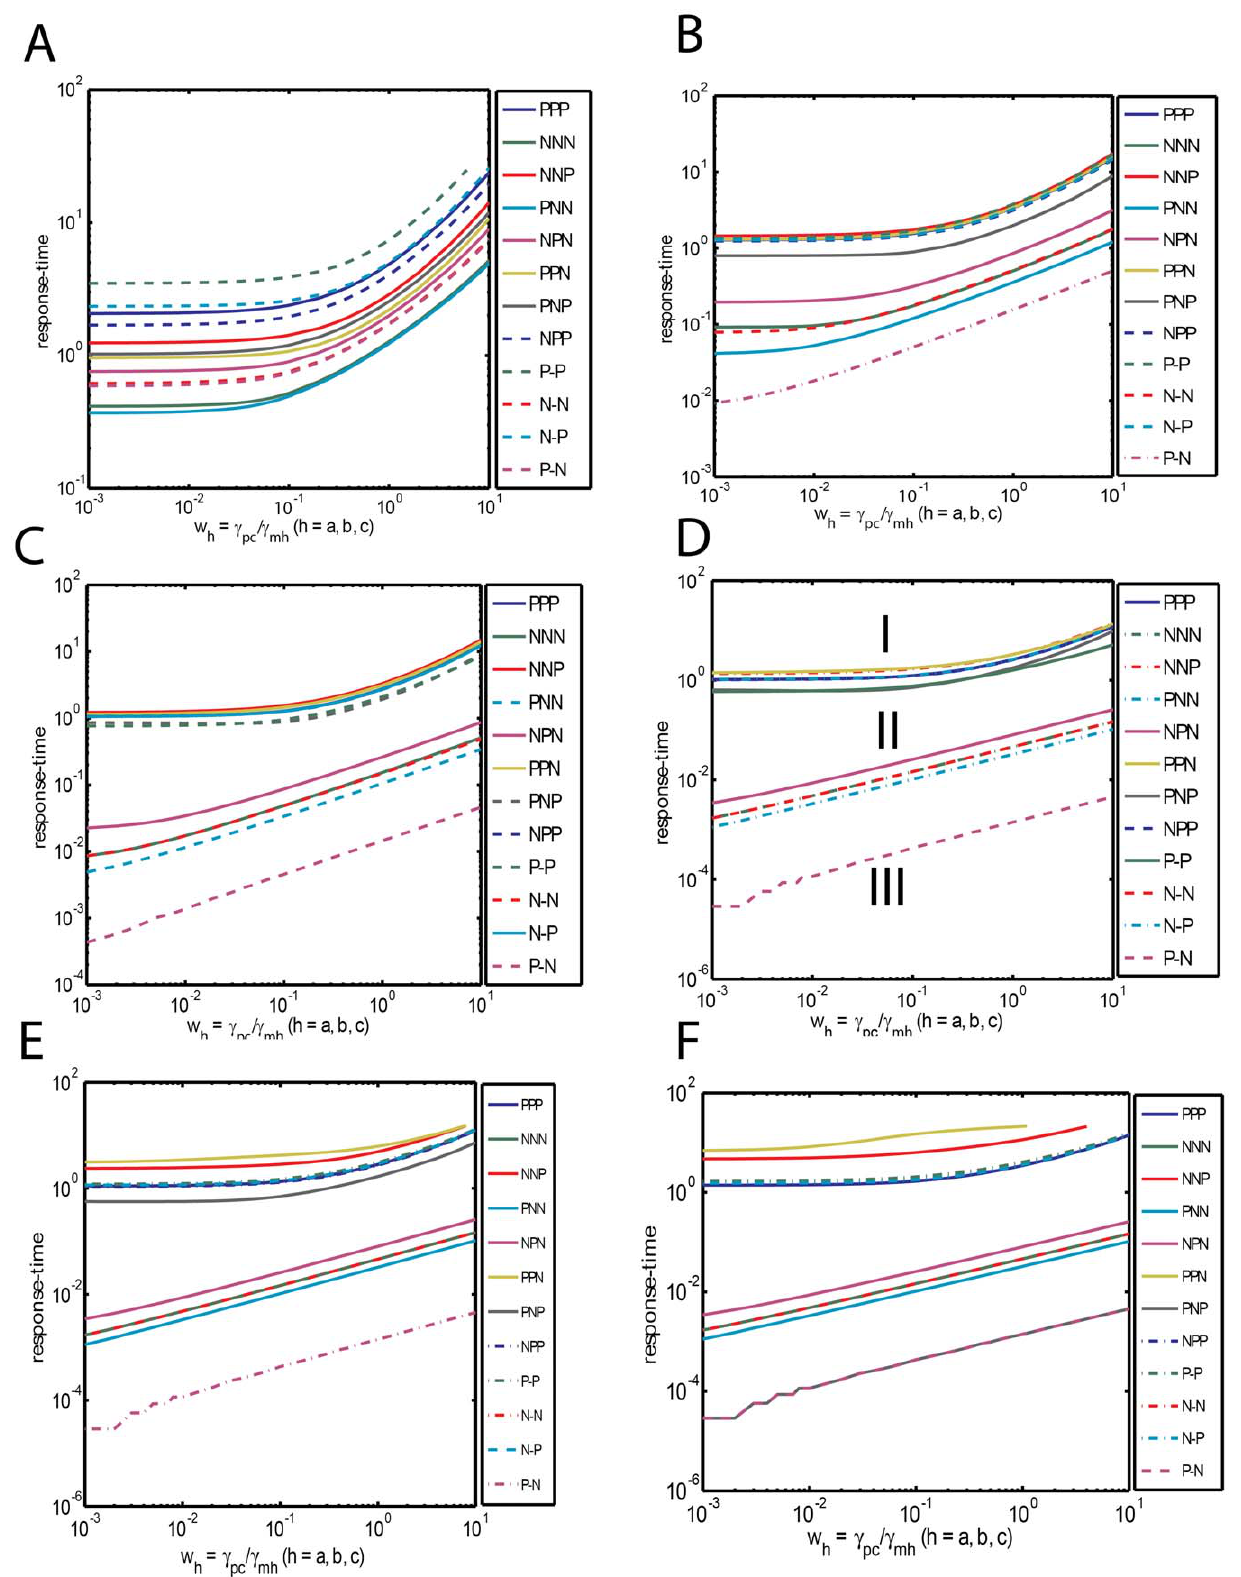
Figure 2. Dependency of response times on various sets of system parameters viz. (cid:2) ww =( w a , w b , w c ), (cid:2) mm =( m ab , m ac , m bc , m yc , L ab ) and (cid:2) vv =( v ba , v ca , v cb , e ab , v cy ). Response times are expressed in terms of number of generation times. A. Dependency of response times of various types of FFLs under weak binding conditions. Here the simulation setting are (cid:2) mm =1, (cid:2) vv =0.0003, (cid:2) ss =4, D t =5 x10 2 6 , the total simulation time was set to T =25